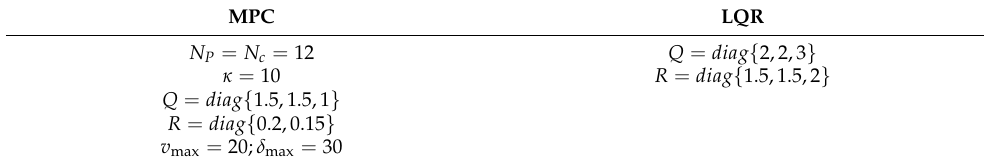
Table 6. MPC and